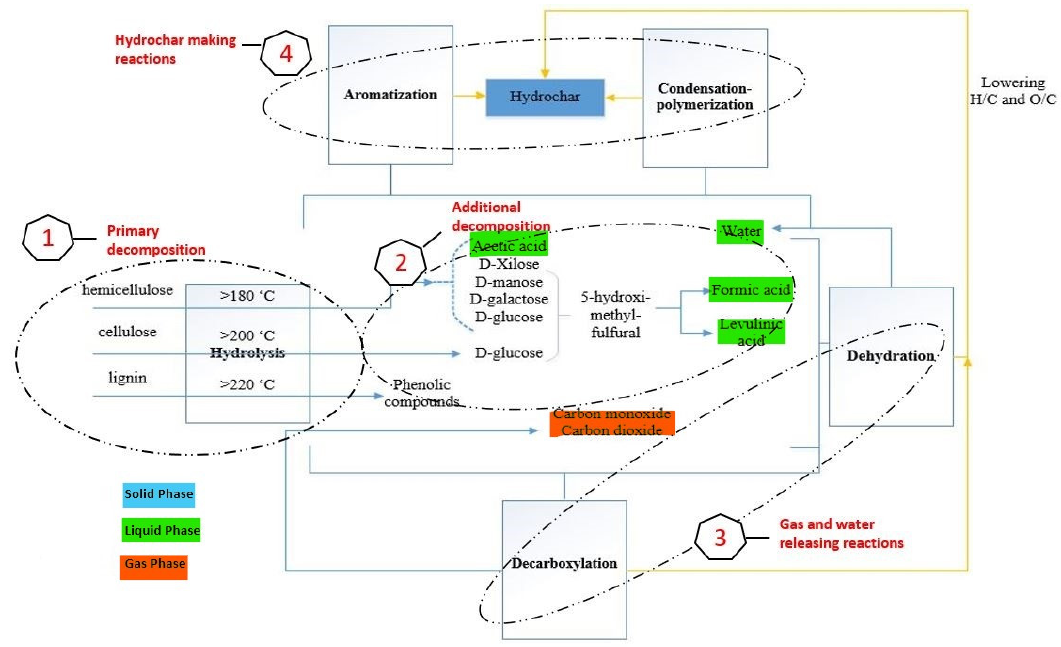
Figure 2. Schematic of the HTC reaction pathway process.